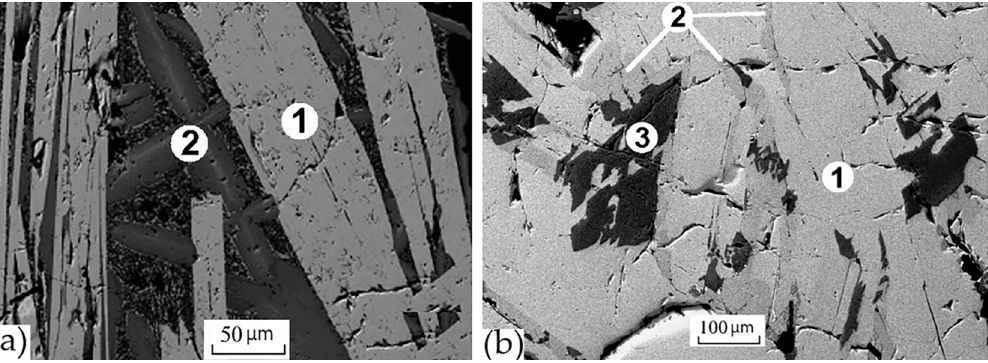
Figure 11. SEM images of the samples ( a ) MT: 1—monoclinic Nd 2 Ti 2 O 7 , 2—zirconolite; ( b ) RT: 1—orthorhombic Nd 4 Ti 9 O 24 , 2—zirconolite, 3—rutile. orthorhombic Nd 4 Ti 9 O 24 , 2—zirconolite,